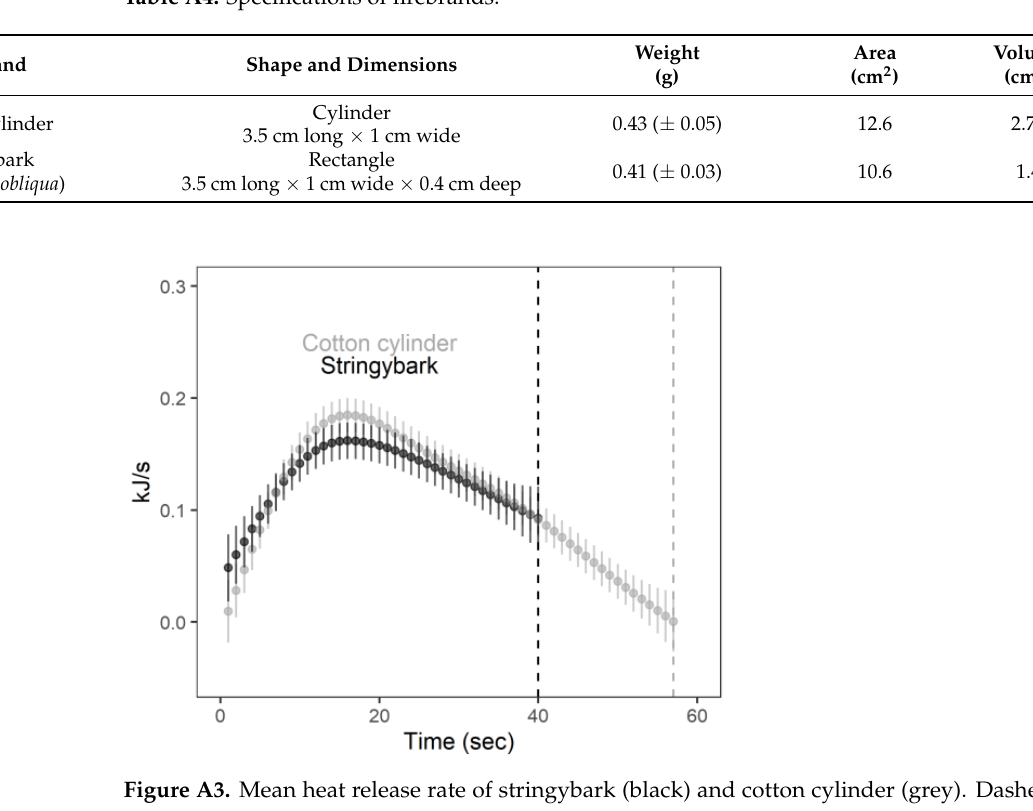
Table A4. Specifications of firebrands.